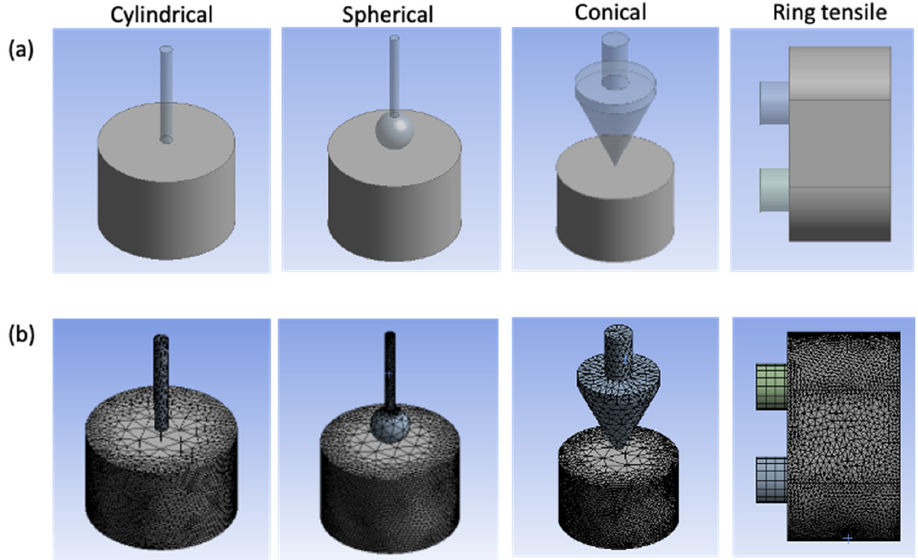
13 of 16 Figure 12. Schematic diagram of an image acquisition system for ( a ) penetration test, and ( b ) ring tensile test. 4.5. Numerical Analysis Ansys 2020 R2 with Explicit dynamic module (Ansys, Inc., Canonsburg, PA, USA) was used to characterize the penetration effect and the failure point for the surimi gel in a penetration test (i.e., using a cylindrical, spherical and conical puncture) and the ring ten- sile test, respectively.